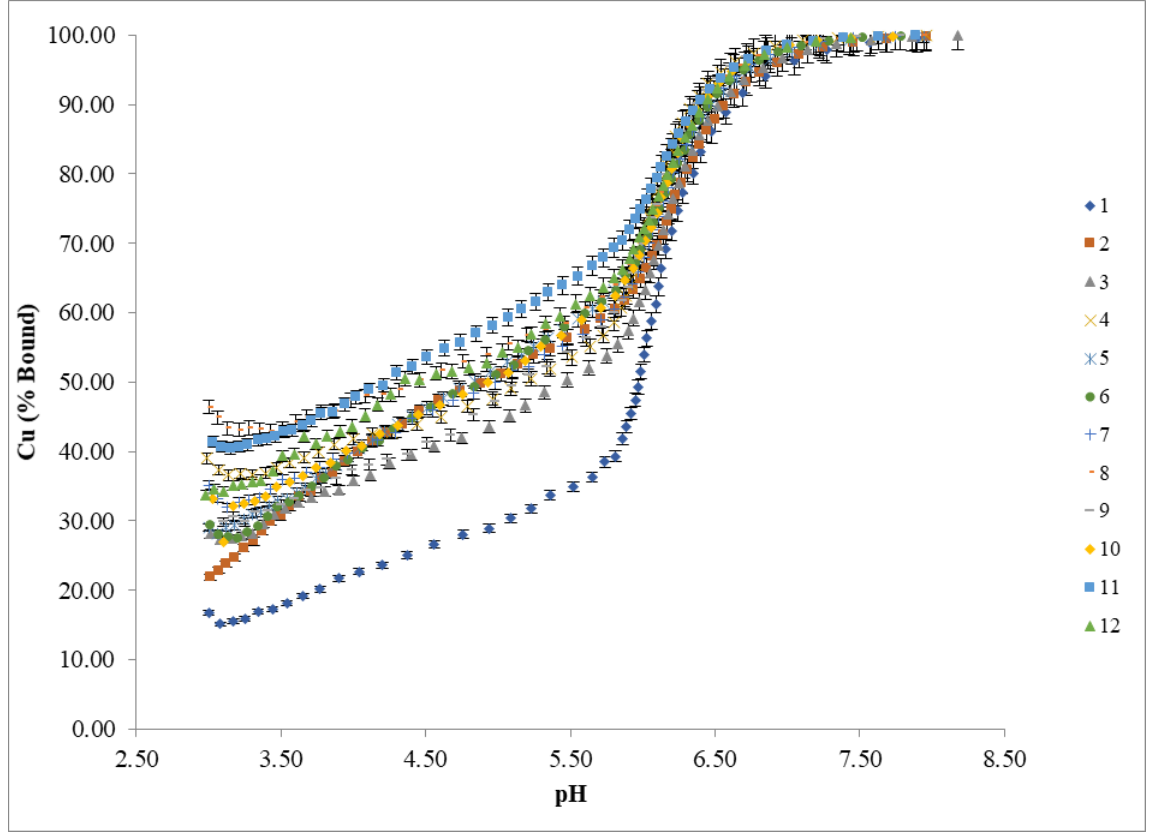
Figure 4. ISE titrations ( n = 3) of bound Cu in proteinates containing 10% ( w/w ) Cu. 1–12 refer to the individual hydrolysates outlined in Table 1.